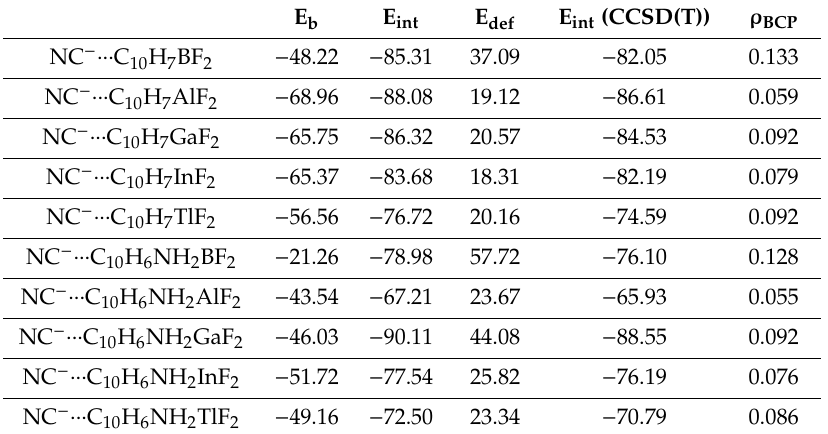
Table 8. Binding, interaction and deformation energies (kcal / mol) and density at Tr ··· C bond critical point (au) of naphthalene derivatives complexed with NC − corrected for